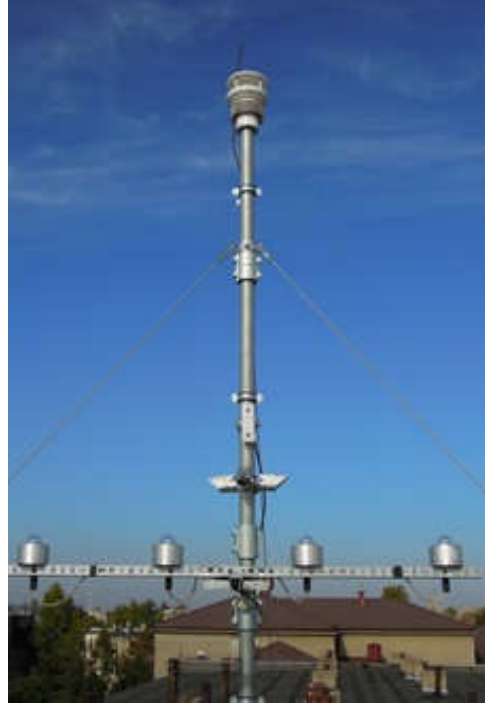
Figure 4. Measuring device for external air conditions.